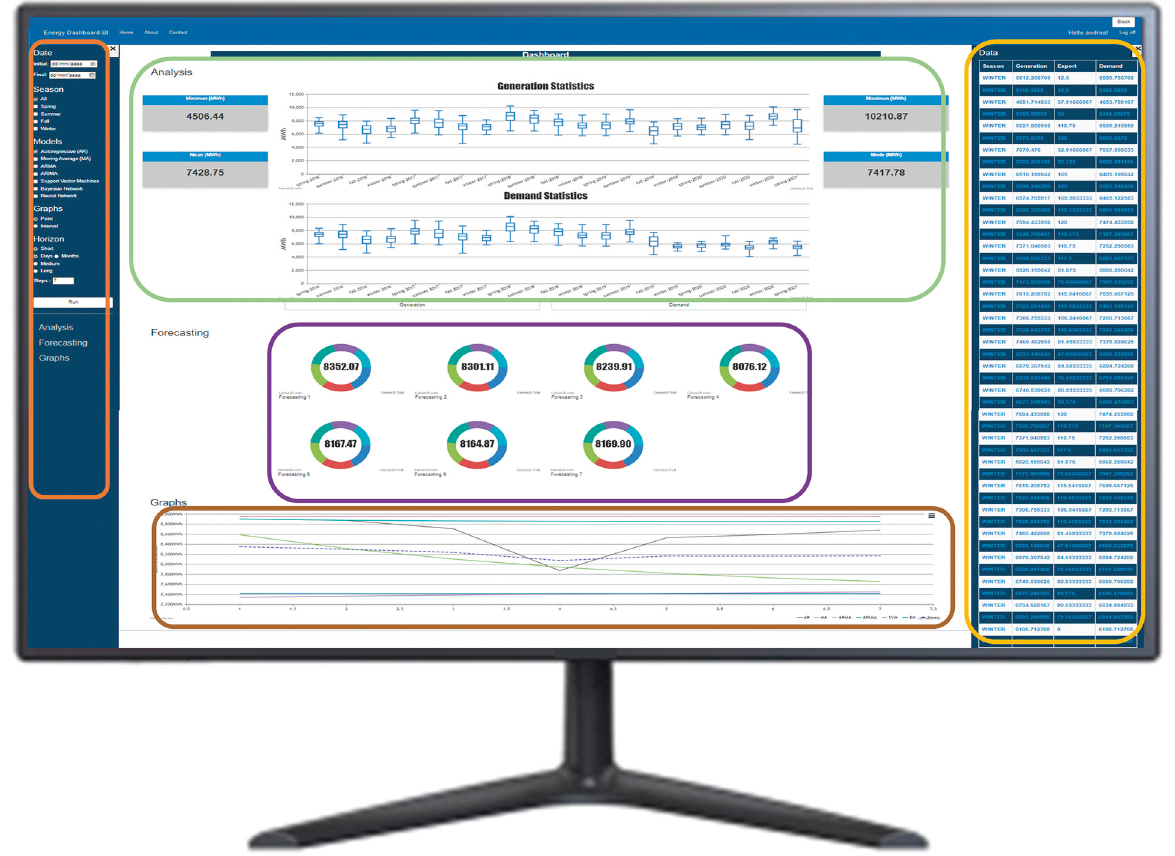
Figure 4: Interactive dashboard of the proposed platform. Table 3: Execution time of each of the implemented